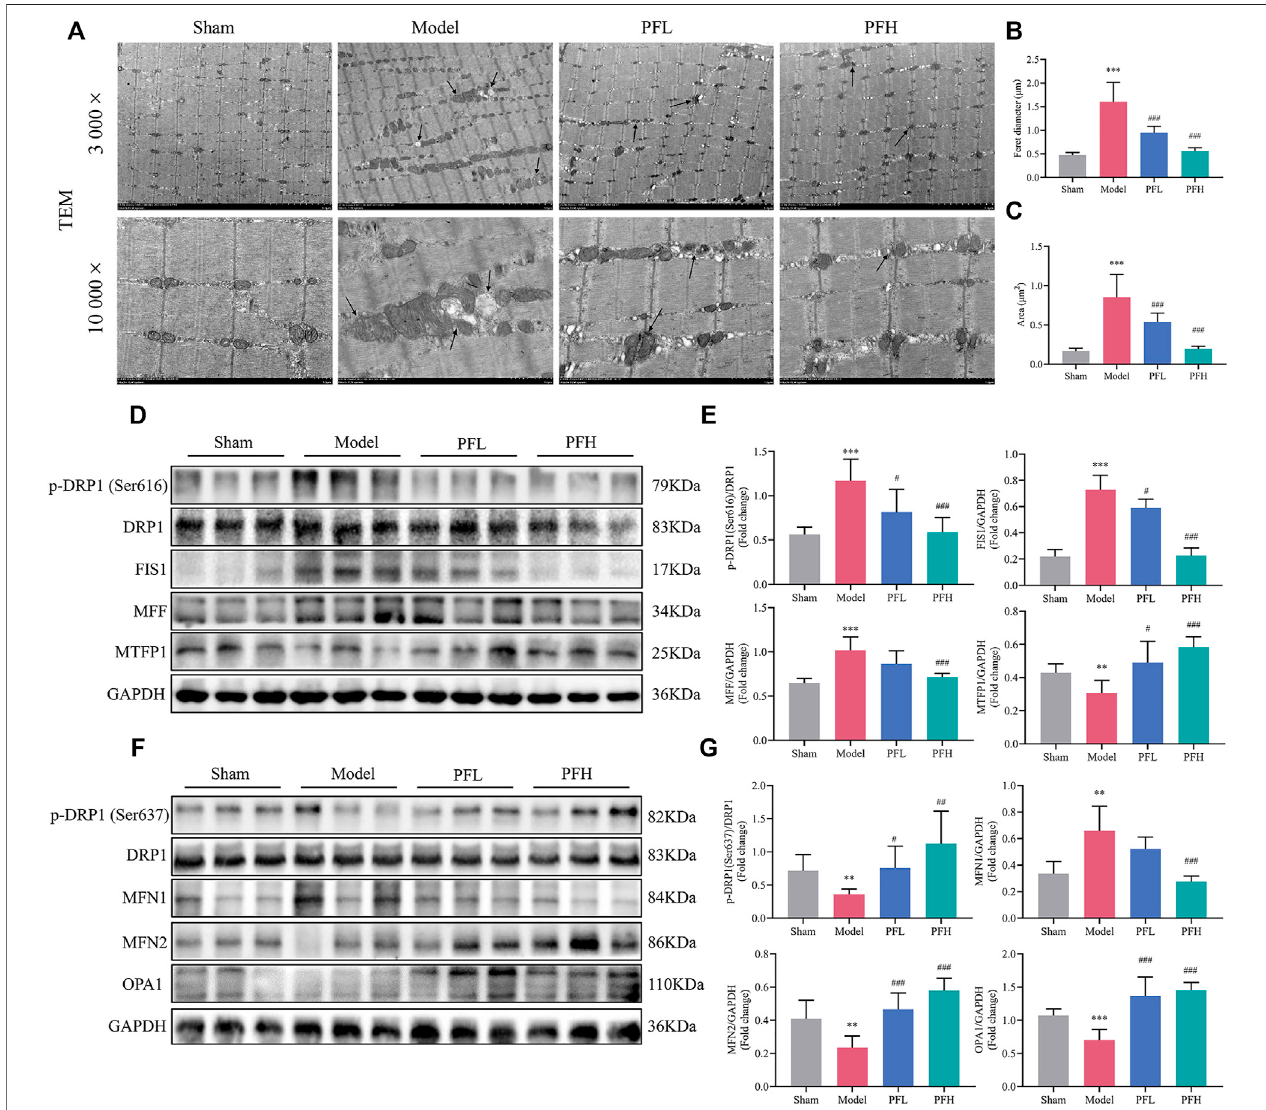
FIGURE 4 | PF ameliorated mitochondrial structural damage and regulated mitochondrial dynamics in CKD rats. (A) Representative electron micrographs. MitochondriawereswollenandshowedadisorderedarrangementandmembranerupturesorlargevacuolesinCKDmodelrats.Theblackarrowsindicatemitochondria (magni fi cation:3,000×and10,000×,scalebars:5and1 μ m). (B,C) ThemitochondrialaverageFeretdiameterandareafromdifferentgroupsinmuscleswerecalculated ( n = 20/group). (D) Representative western blots using antibodies against DRP1 phosphorylation at Ser616, DRP1, FIS1, MFF, MTFP1, and GAPDH. (E) Western blotquanti fi cationoftheexpressionofmitochondrial fi ssion-relatedproteins,includingp-DRP1(Ser616),DRP1,FIS1,MFFandMTFP1. (F) Representativewesternblots usingantibodiesagainstp-DRP1(Ser637),DRP1,MFN1,MFN2,OPA1,andGAPDH. (G) Theexpressionofmitochondrialfusion-relatedproteins.Allproteinexpression wasnormalized to that of GAPDH as aloading control ( n = 6). All of the data are expressed as the means ± S.Ds. Signi fi cant differences are indicated as * p < 0.05, ** p < 0.01, *** p < 0.001 vs. the Sham group. # p < 0.05, ## p < 0.01, ### p < 0.001 vs. the Model group.